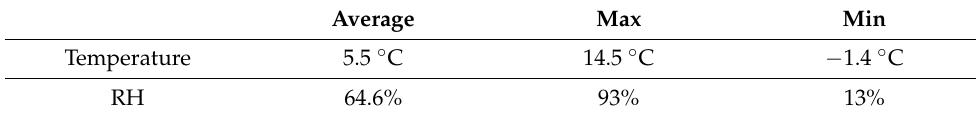
Table 10. Statistics of indoor environmental parameters for W3.